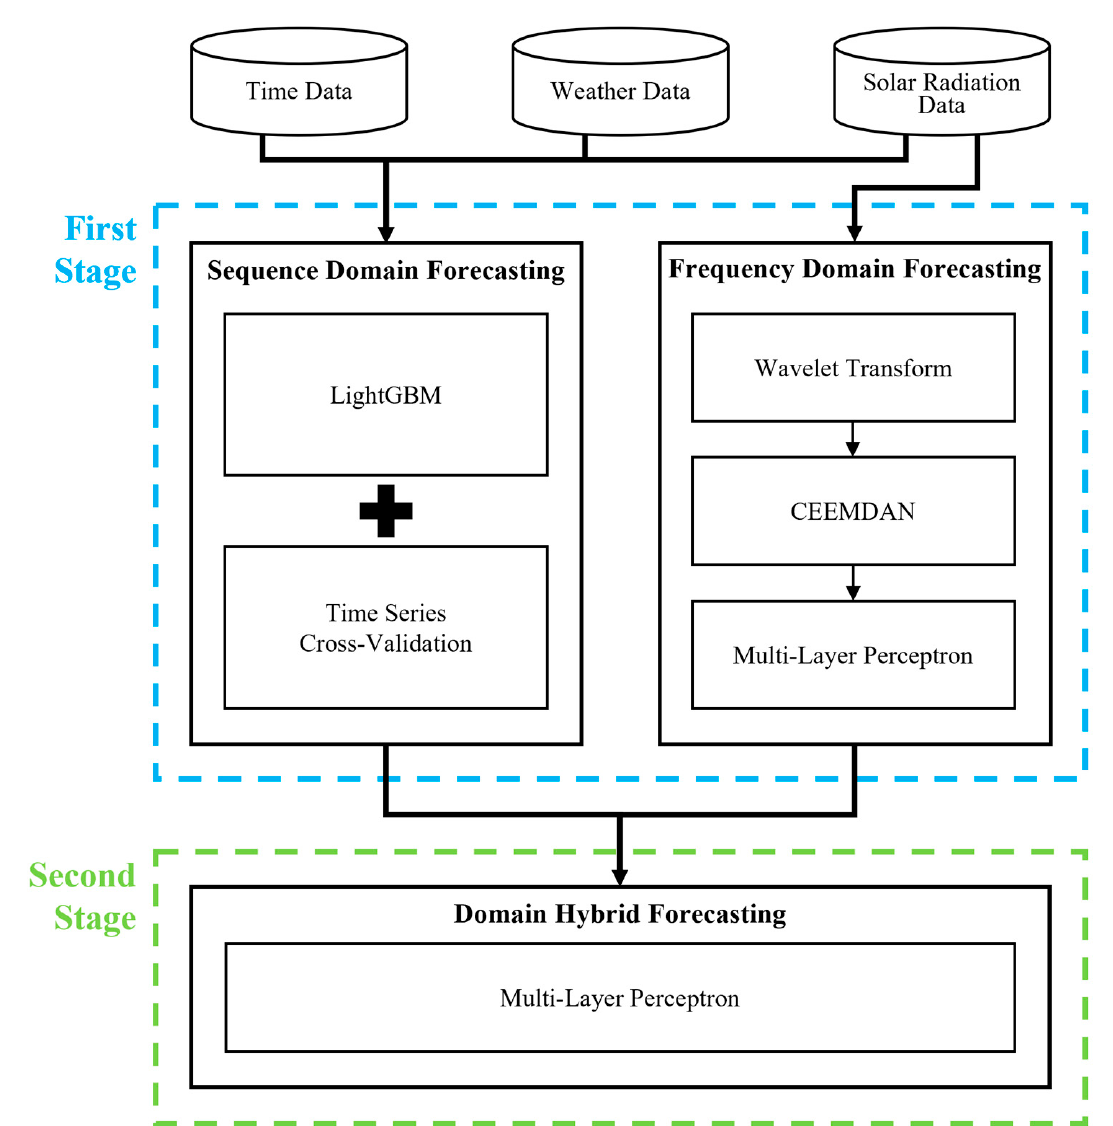
Figure 1. Architecture of the proposed domain hybrid day-ahead solar radiation forecasting model.